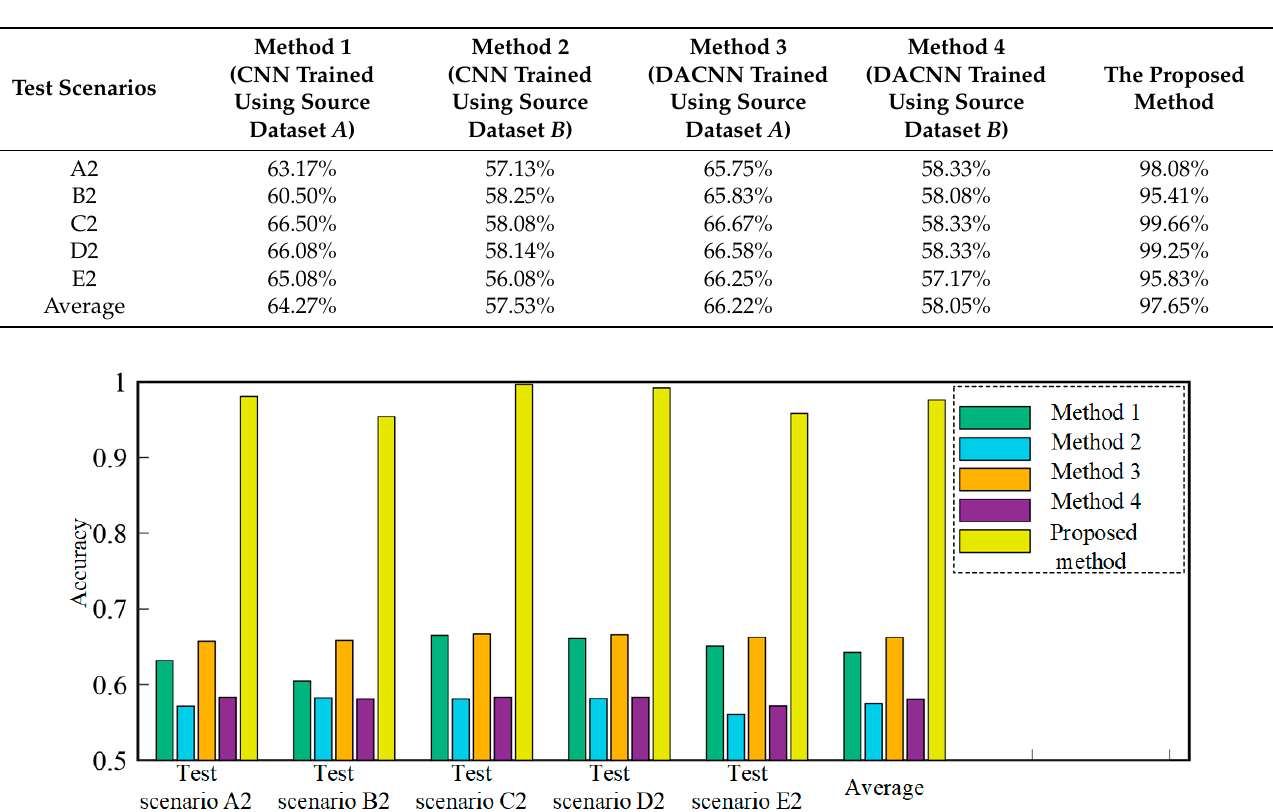
Table 13. Results of different methods.